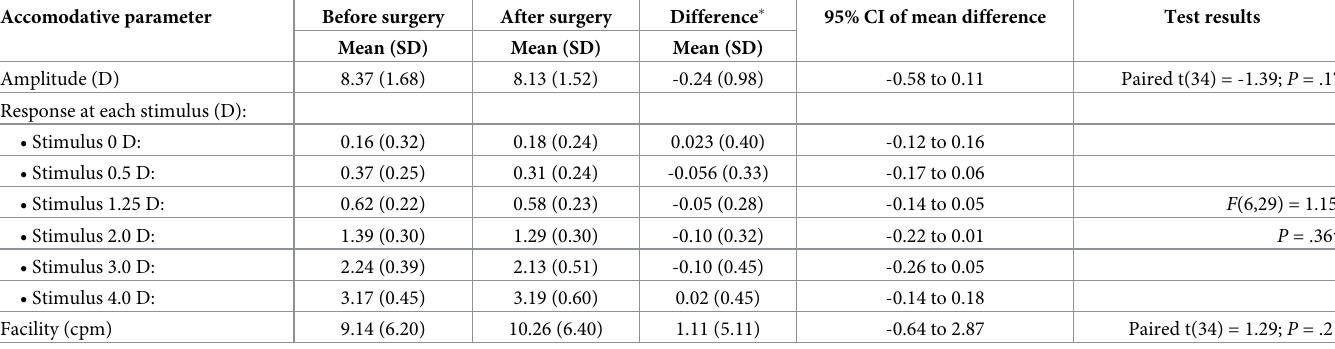
Table 2. Assessment of accommodation.